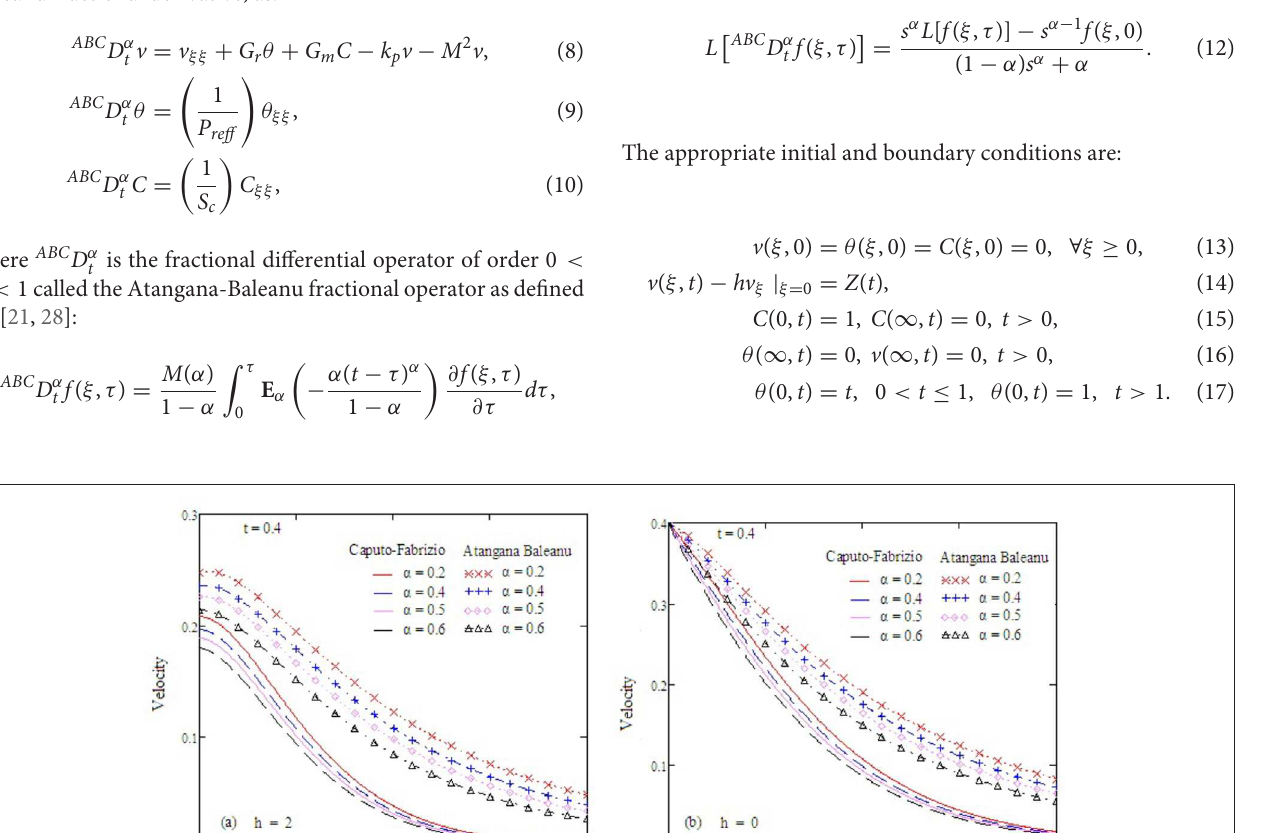
FIGURE 3 | Velocity profiles with altered values of α and other parameters are k p